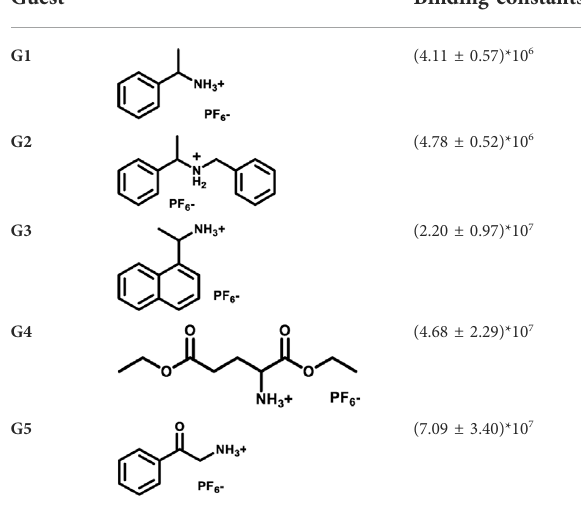
TABLE 1 The binding constants of the guest cations and the fl uorescent macrocycle